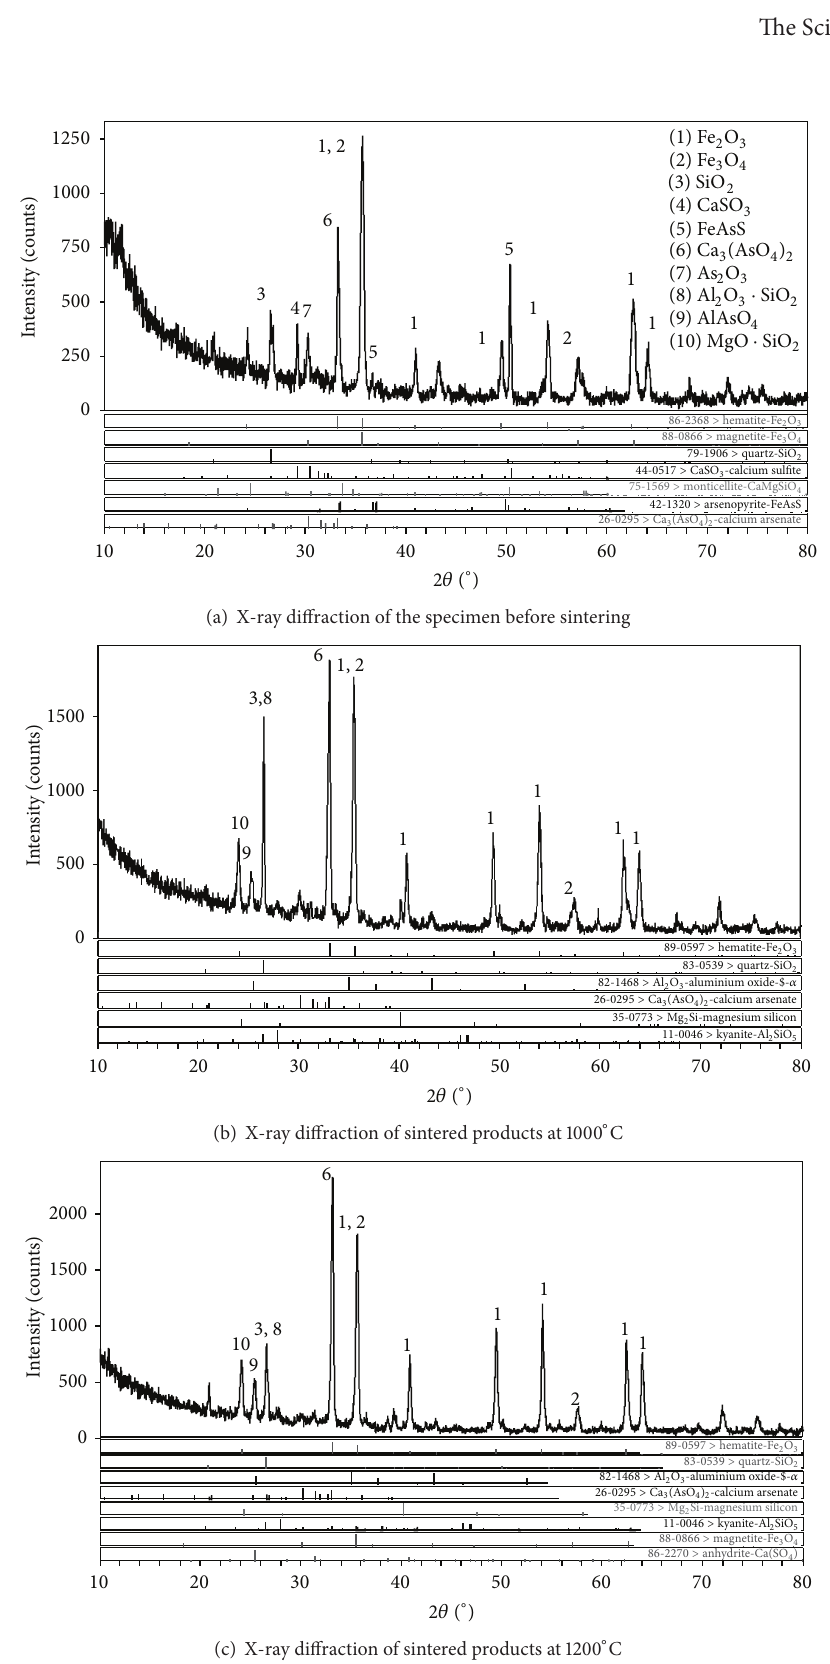
Figure 6: X-ray diffraction of sintered products at different sintering